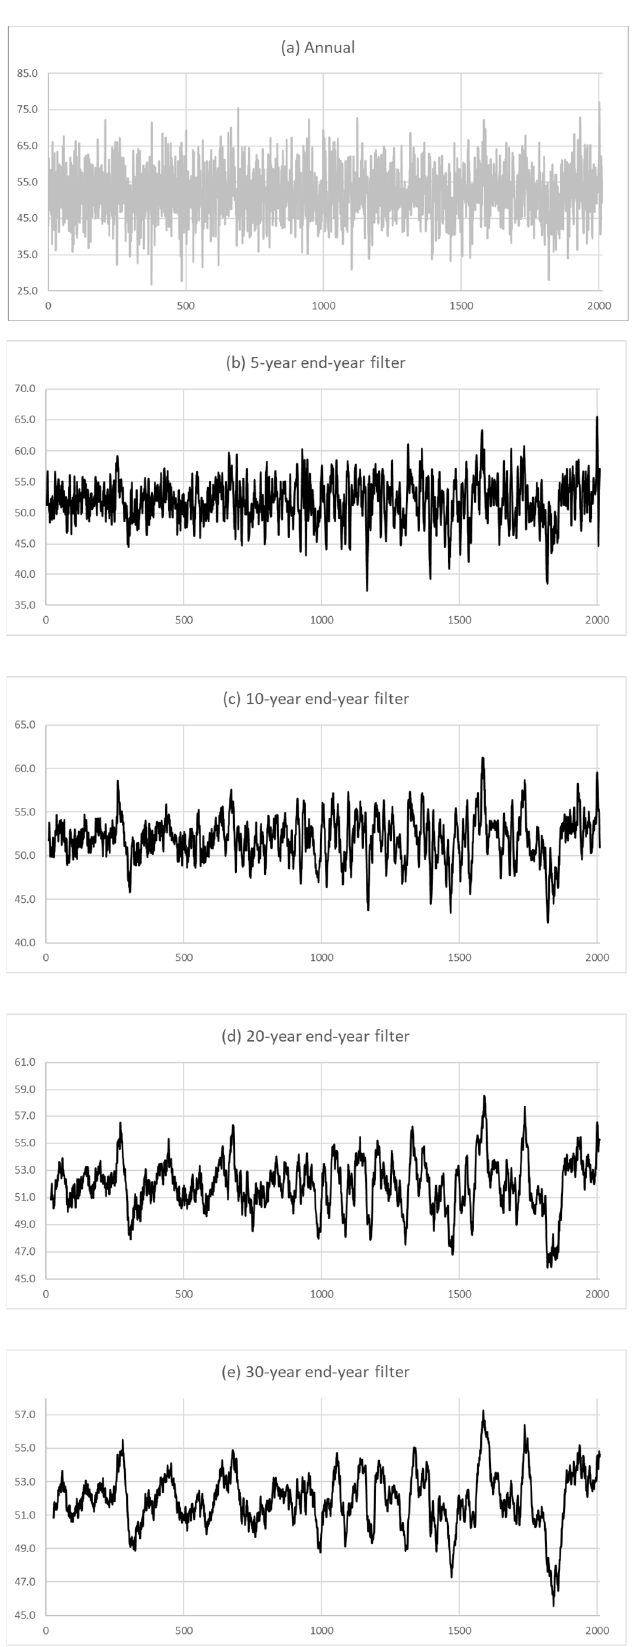
Figure 4. Reconstructed Adige/Etsch (Sigmundskron)—Year versus Flowrate (m 3 /s) from 0 to 2012 AD for ( a ) Annual, ( b ) 5-year, ( c ) 10-year, ( d ) 20-year and ( e ) 30-year end-year filters.